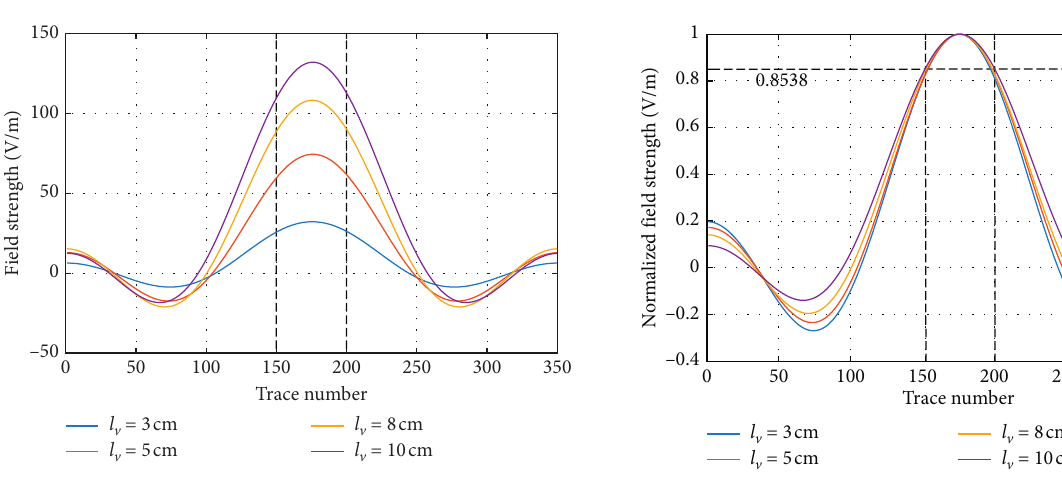
Figure 7: Forward and preprocessing results: (a) forward result, l (d) forward result, l v � 10cm; (e) preprocessing result of (a); (f) preprocessing result of (b); (g) preprocessing result of (c); (h) preprocessing result of (d).